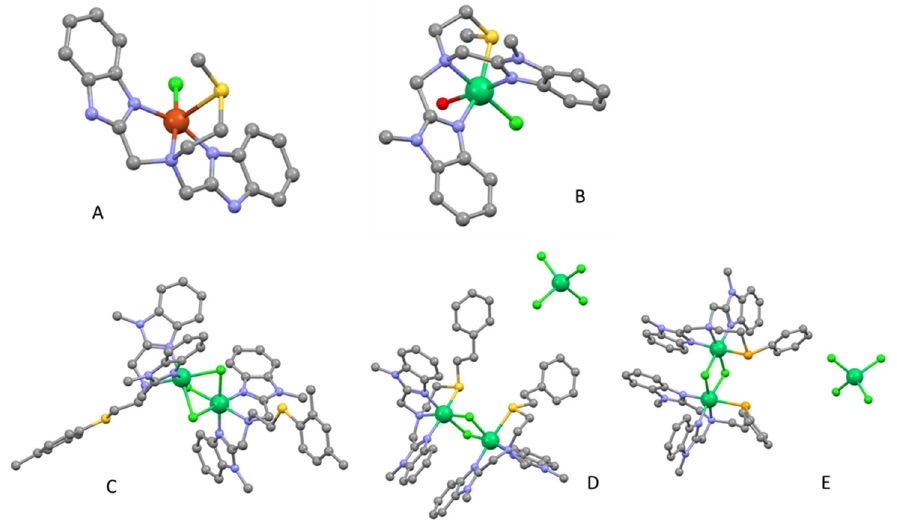
Figure 1. Molecular structures of ( A ) [L 1 CuCl]; C (gray), N (blue), S (yellow), Cl (green), and Cu (red), ( B ) [Ni(L1 Me )(H 2 O)(Cl)]Cl, Ni (great green), O (red), ( C ) Ni 2 (L2 Me ) 2 ( µ -Cl) 3 ]Cl, ( D ) [Ni 2 (L3 Me ) 2 ( µ